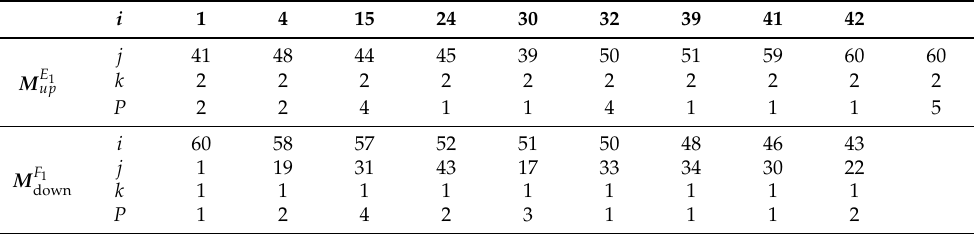
Table 10. Scheduling tasks of Elevator-EF in the first half